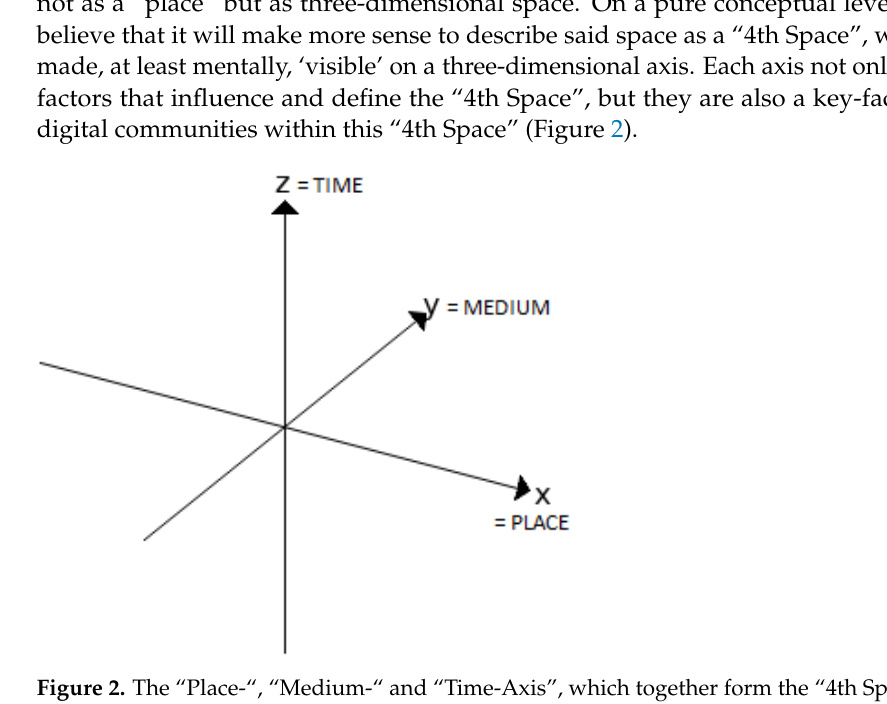
Figure 2. The “Place - “, “Medium - “ and “Time - Axis”, which together form the “4th Space”